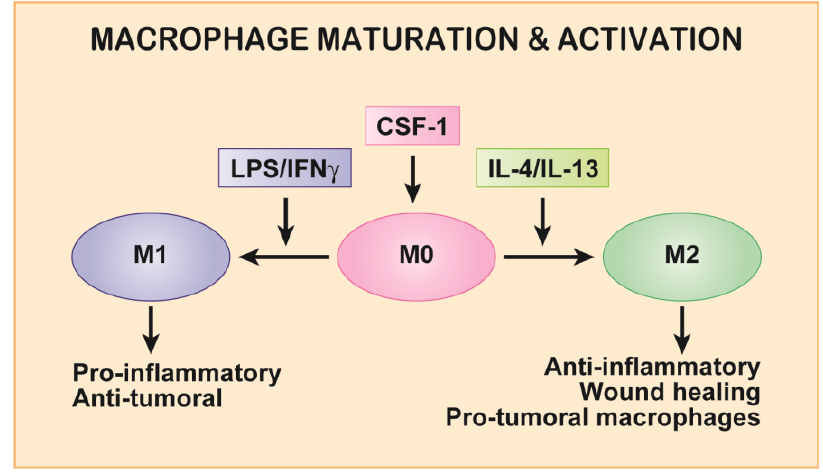
Figure 1. Colony-stimulating factor-1 (CSF-1) induces macrophage precursors to mature into adherent, motile baseline macrophages (M0). M0 macrophages are then activated into pro-inflammatory macrophages by IFNγ and LPS or anti-inflammatory, pro-tumoral macrophages by IL-4 or IL-13. Definitions: LPS, lipopolysaccharide; IFNγ, interferon-γ; IL, interleukin.